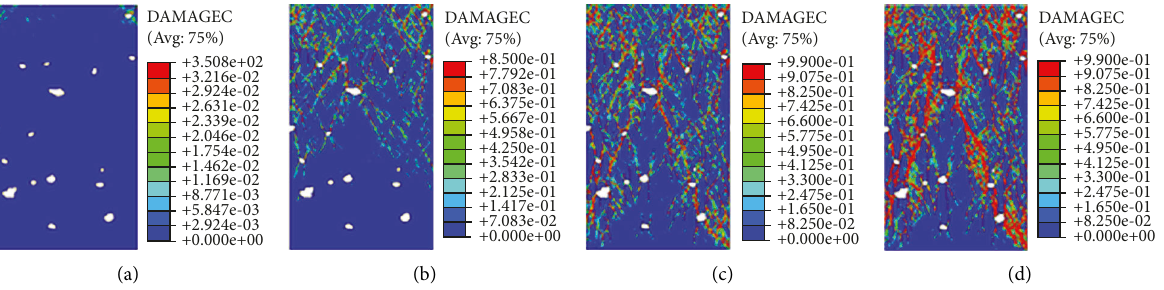
Figure 16: Damage failure graphs under different loading displacement. (a) s � 0.02mm. (b) s � 0.137mm. (c) s � 0.533mm. (d) s � 1mm.